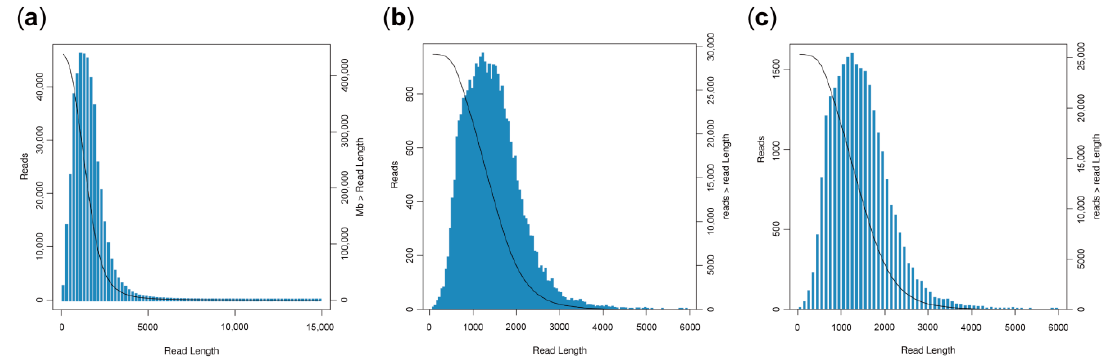
Figure 2. The length distribution of PacBio single-molecule long-read (SMRT) sequencing. ( a ) Length distribution of circular consensus sequences (CCSs). ( b ) Length distribution of consensus